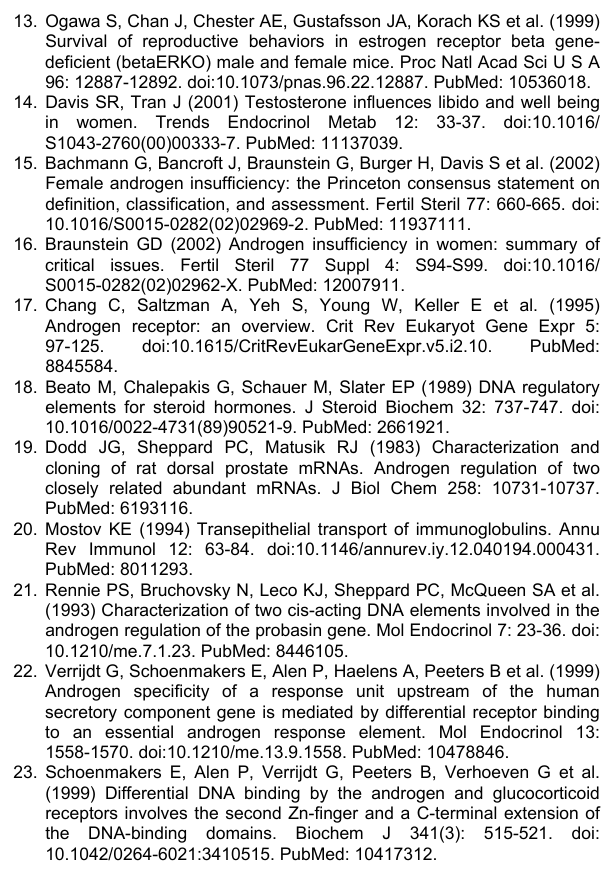
Figure S3. Analysis of luciferase activity and expression in mouse ARE-Luc primary cells in culture. A , Relative mRNA expression of steroid hormone receptors in gonadal pre- adipocytes. B , Luciferase activity in gonadal adipose cells grown under conditions of hormone starvation for 72 hours and treated with 10nM hormone for 24 hours. C , Luciferase expression in various primary cell types, hormone-starved for 72 hours and treated with mibolerone (10nM) or equivalent volume vehicle (Eth) for 24 hours.